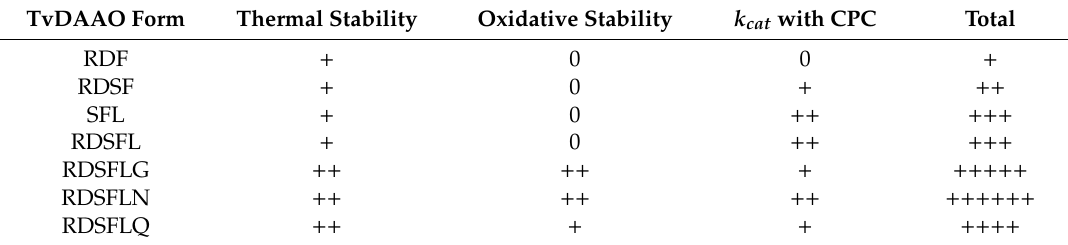
Table6summarizesinputofeachmutationtothefinalpropertiesofnewmultipointTvDAAOmutants. Table 6. Comparison of the properties of the TvDAAO mutants with wt-TvDAAO. TvDAAO